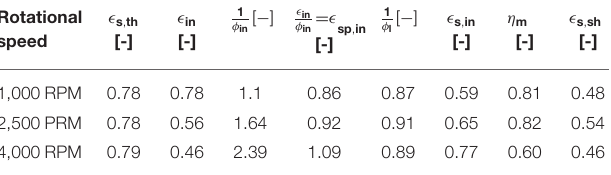
losses are computed with Equation (10), which allows for the TABLE 4 | Summary of losses